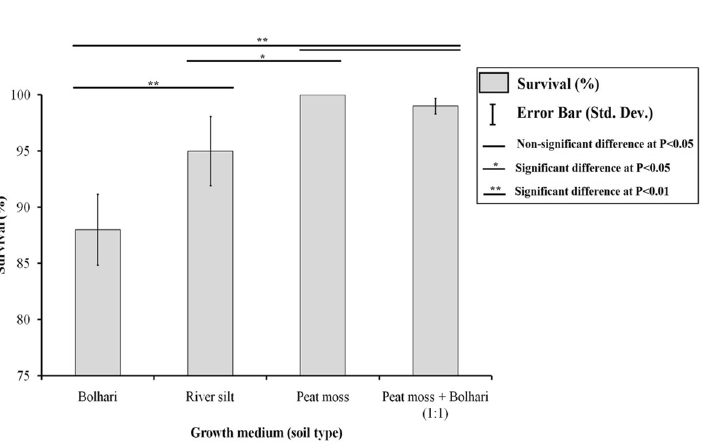
Figure 6. Effect of different soil types on ex vitro survival percentage of pineapple plantlets during